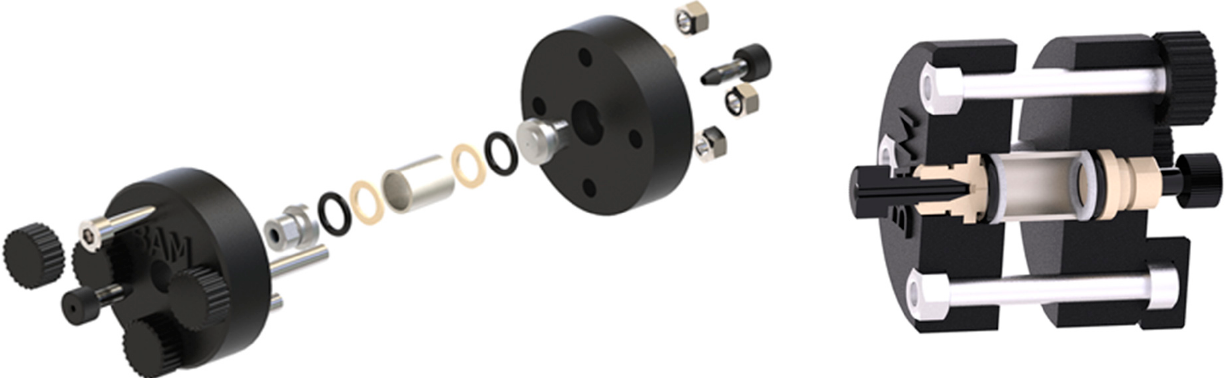
Figure 2. Engineering drawing of the column holder made by additive manufacturing with custom 1/16” PEEK fittings and monolithic affinity column in the center.